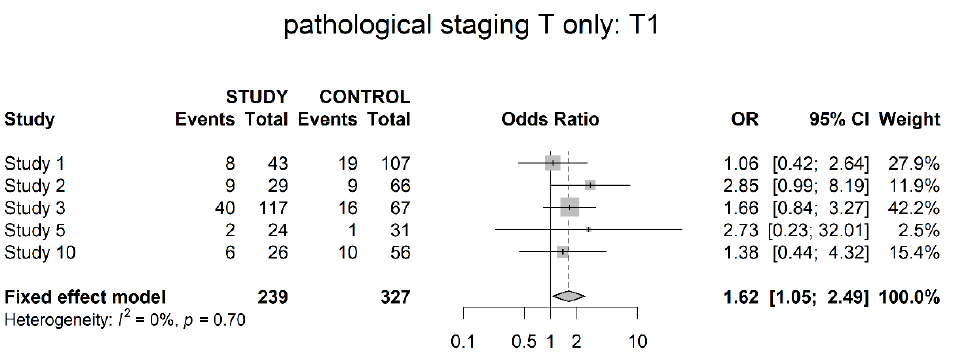
Figure 3. Pathological stage T1 (non-muscle invasive).